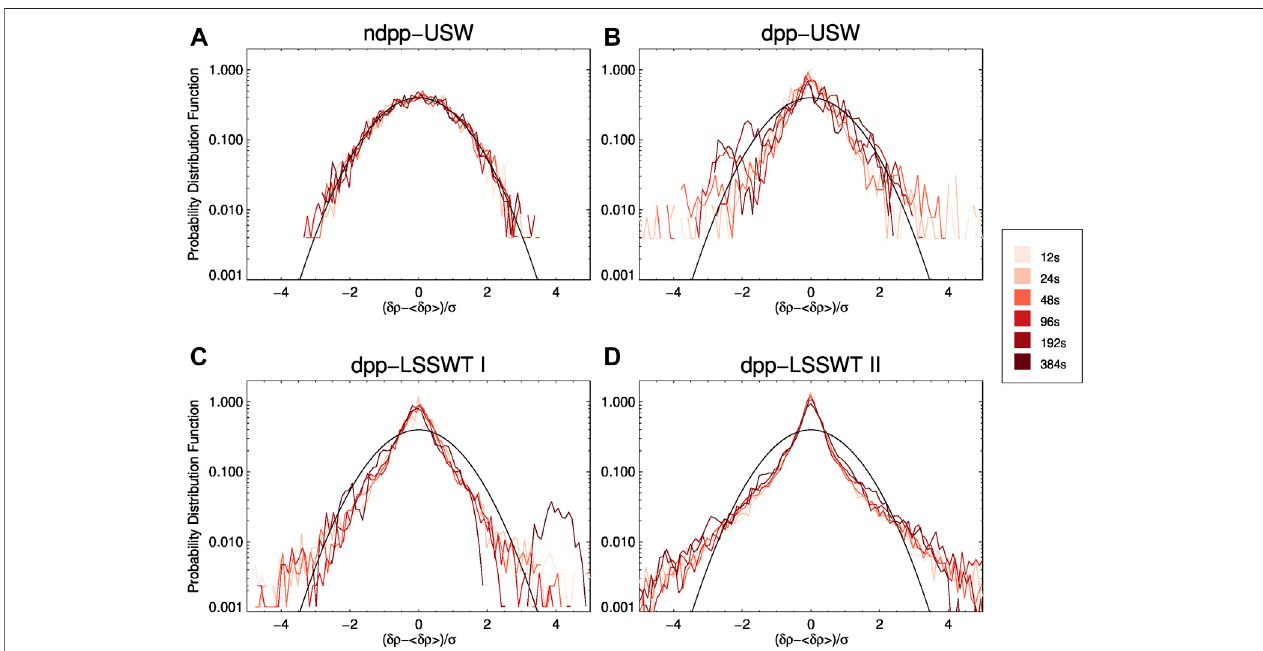
FIGURE 5 | Probability distribution functions of solar wind proton density increments normalized to the standard deviation for different time lags of ndpp-USW region (A) ,dpp-USWregion (B) anddpp-LSSWTIregion (C) anddpp-LSSWTIIregion (D) .Thetimeintervalsoffourdistinctregionsarepresentedin Figure4 .Theblack curve is the standard Gaussian distribution with unit variance. The different degrees of red lines illustrate the actual distribution function between different time lags ranging from 12 to 384 s.